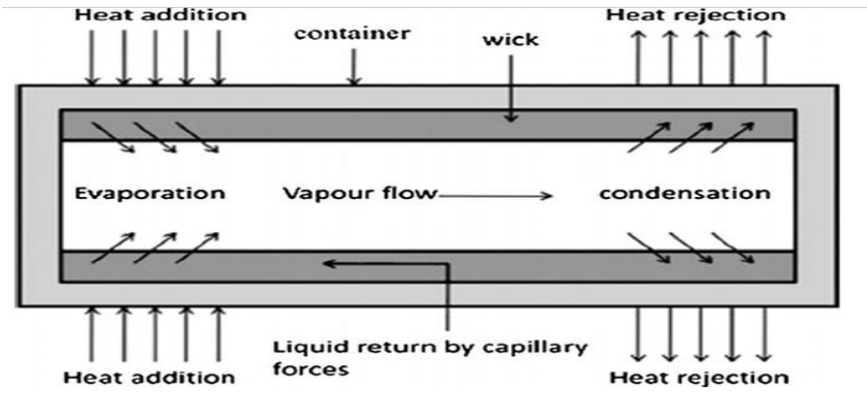
Figure 3. Heat pipe schematic.